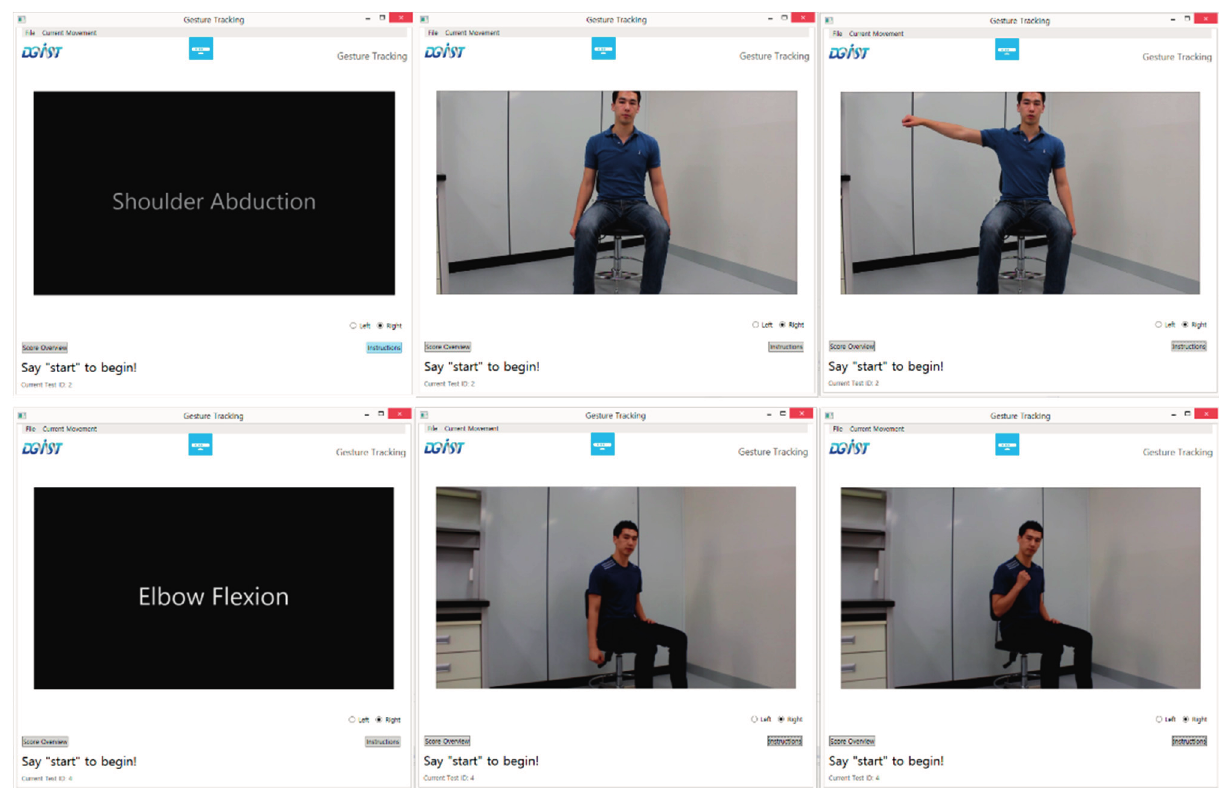
Figure 2. Example frames from an instruction video that is displayed to subjects. They are expected to follow along to perform each test